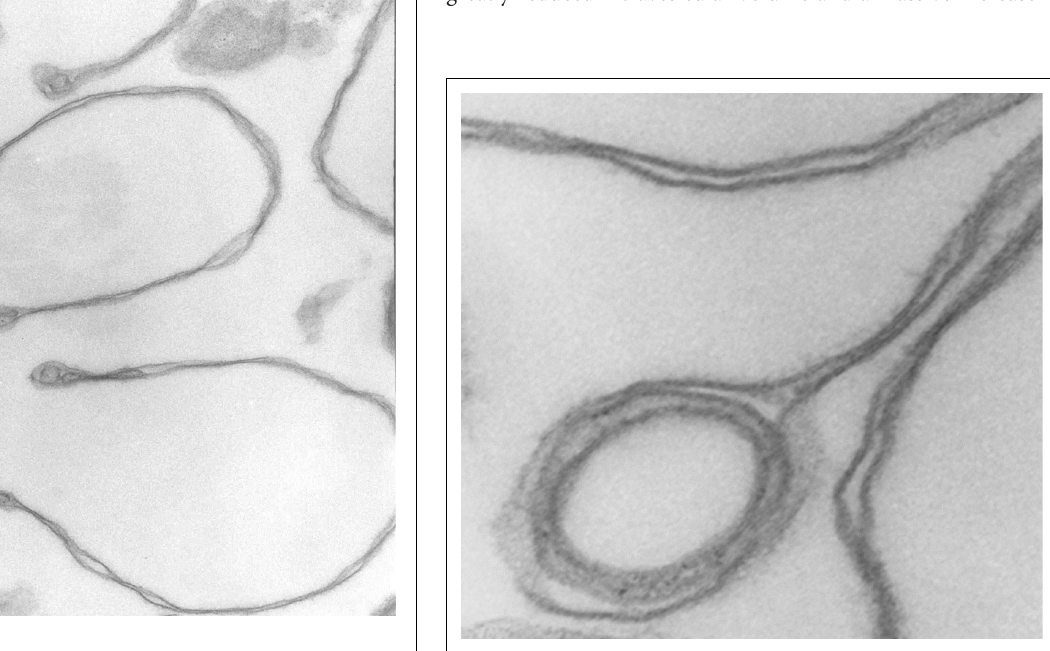
FIGURE 3 | Detail of cup rim and double membranes. Transmission electron micrograph showing details of membrane apposition proximities in collapsed vesicles and of a small internal vesicle with a collapsed double membrane displaced toward the rim of the larger host vesicle shaping the bulge of the rim at that point.